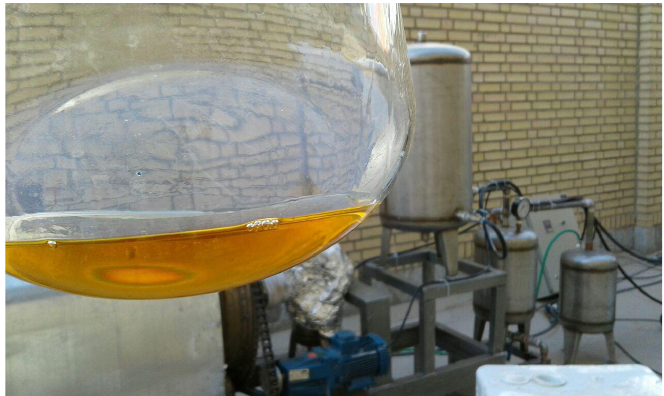
Figure 1. RCC pilot and its